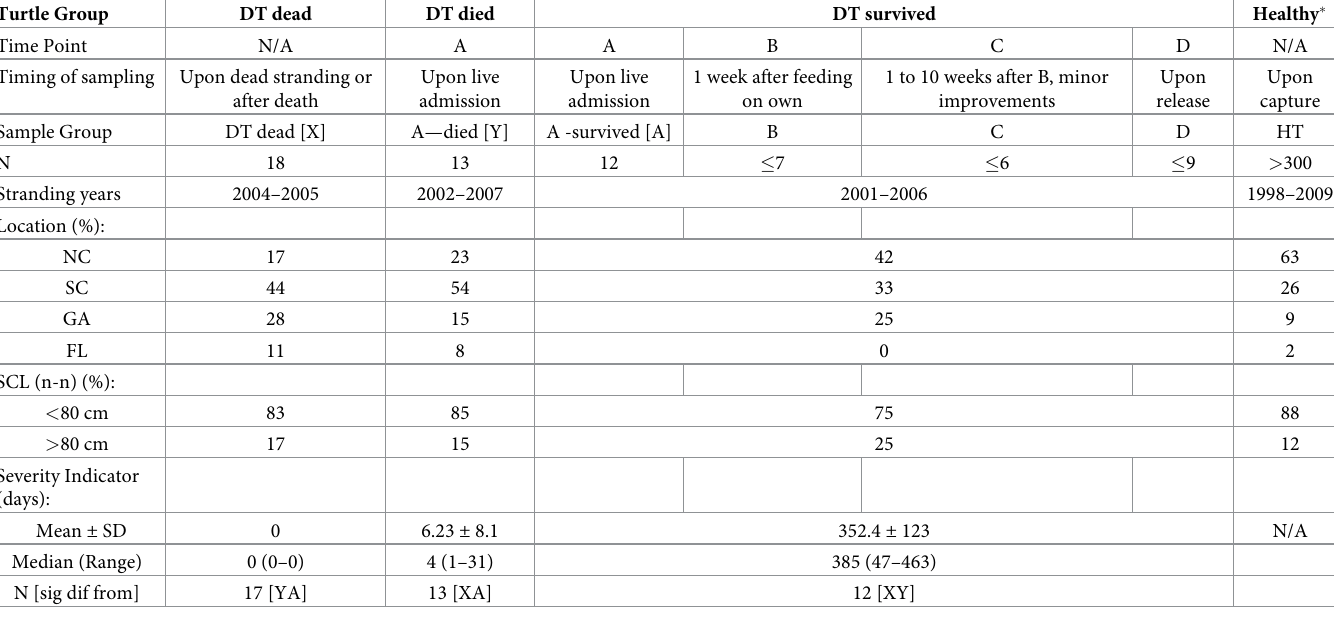
Table 1. Sample sizes and characteristics of debilitated (DT) and healthy loggerhead turtles sampled in the current study. Turtle Group